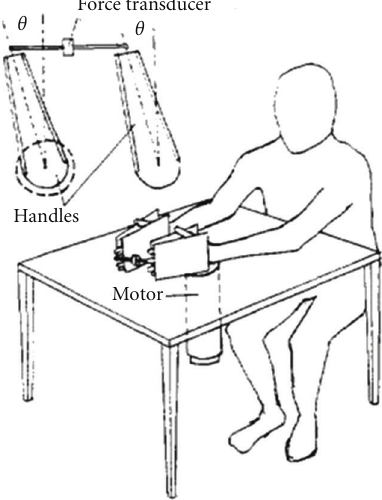
Figure 7: H-O-H. Inset: top-view of the force transducer between the distal parts of the handles. Reprinted with permission.